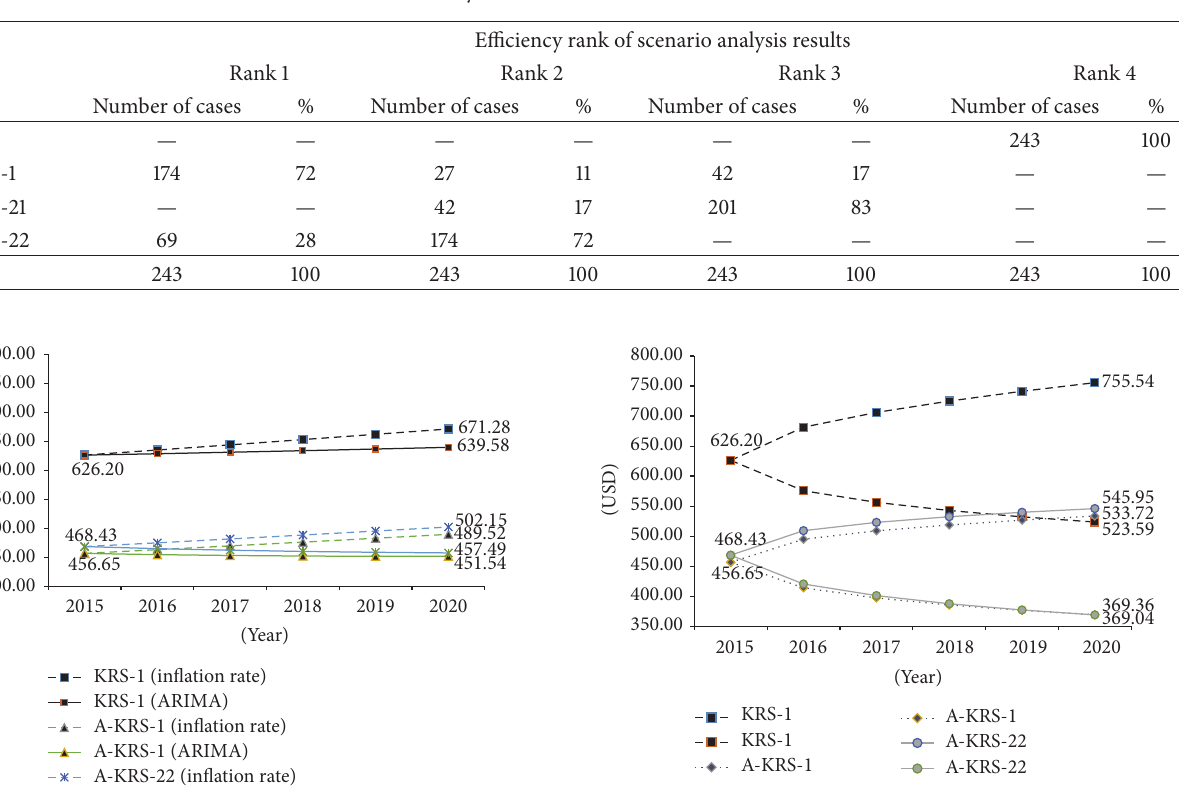
Table 7: The results of efficiency rank for 2020 at 68% confidence interval scenario.